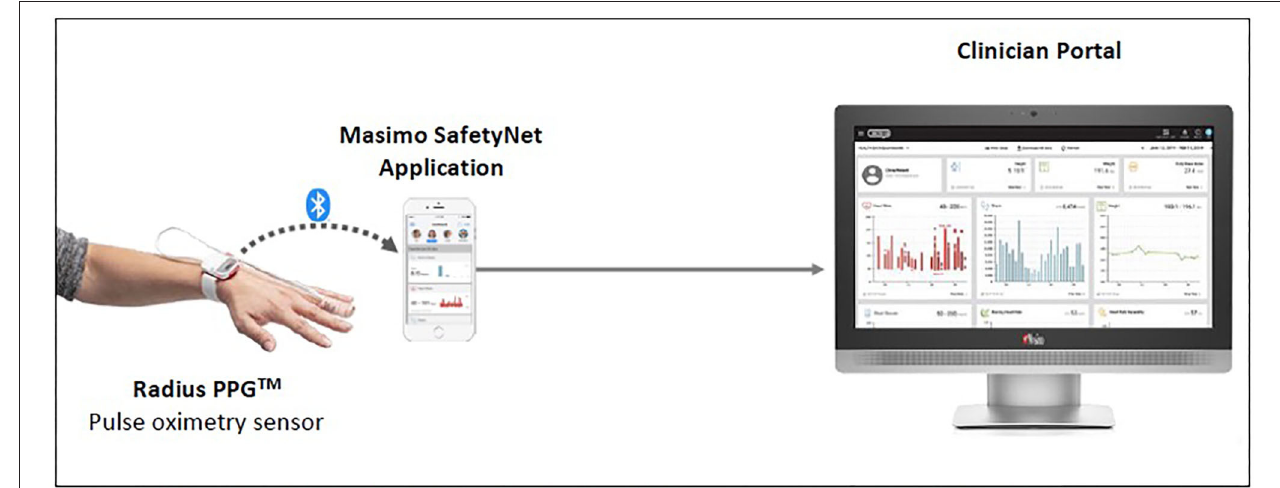
FIGURE 3 | Masimo SafetyNetTM (1) ( Reproduced with permission from Masimo